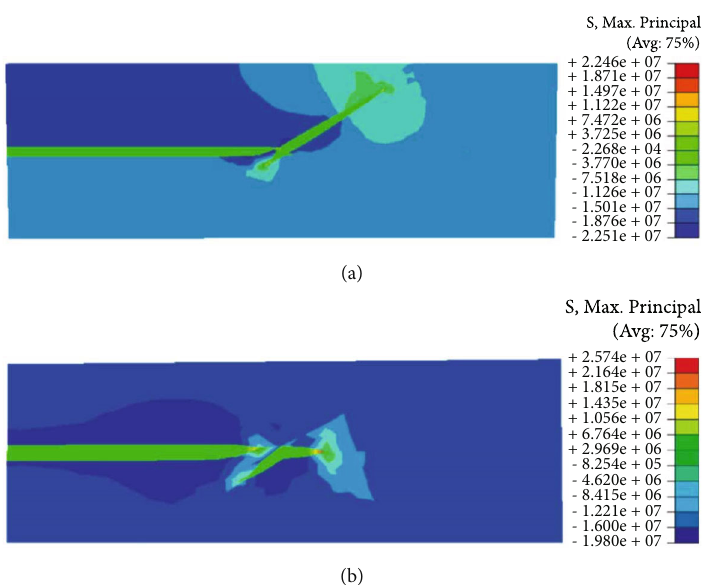
Figure 9: The comparison of contour plots of maximum principal stress between 4m and 15 m formation thickness with a 30-degree approaching angle (deformation scale factor = 100 ): (a) 4m formation thickness and (b) 15 m formation thickness.